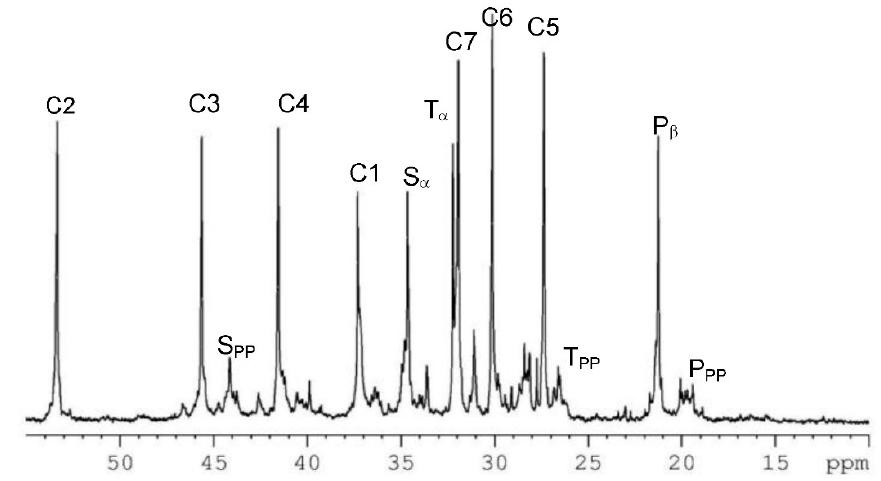
Figure 7. The 13 C NMR spectrum of a P- co -N copolymer obtained by 1 containing 41 mol % of N [34].